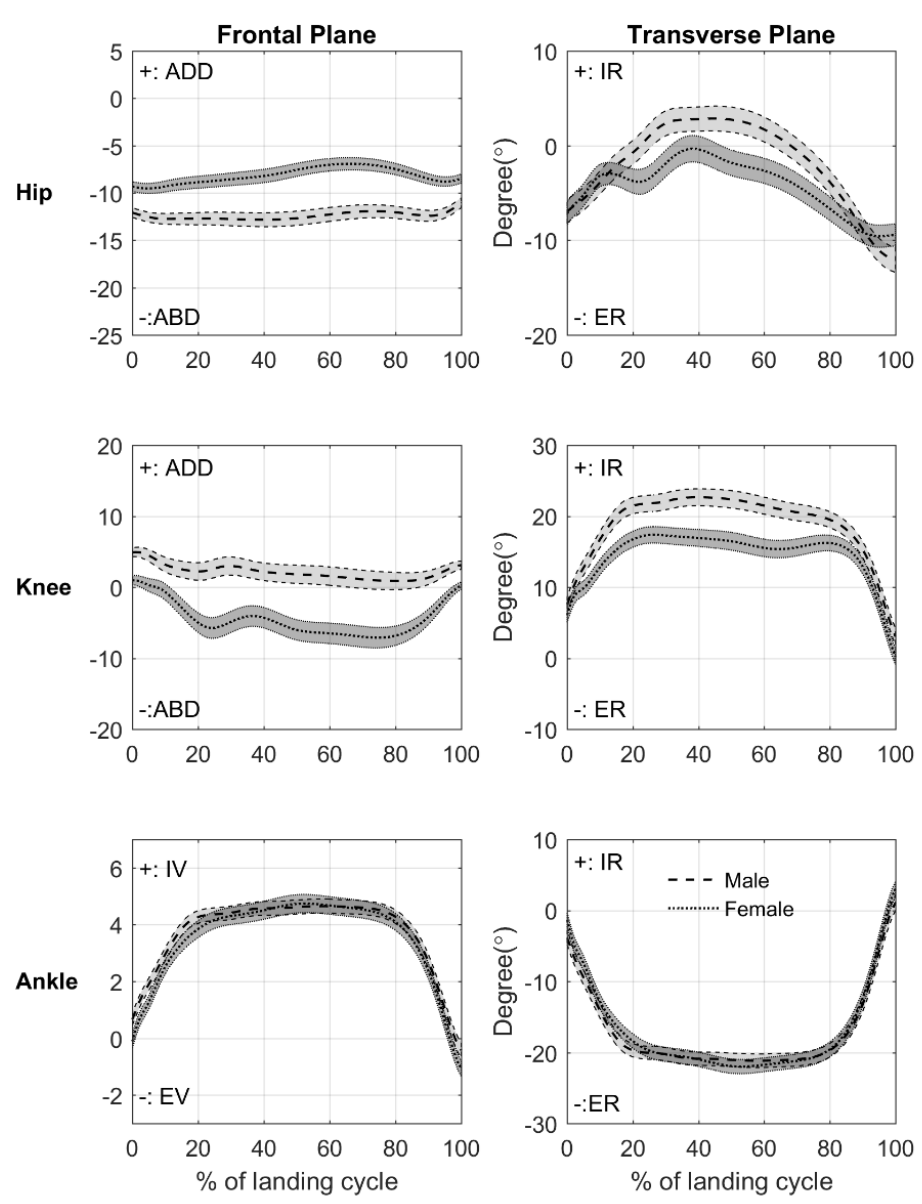
patterns between limbs regardless of sex (Figure 3). The non-dominant limb displayed increased hip abduction (0% to 100% of cycle), knee abduction (10% to 89% of cycle), hip external rotation (0% to 38% and 56% to 100% of cycle), knee internal rotation (0% to 100% of cycle), reduced ankle external rotation (4% to 7% of cycle), and increased ankle internal rotation (97% to 100% of cycle). There was no bilateral difference in ankle frontal plane angle pattern.